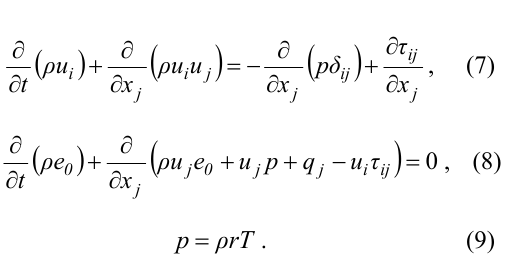
Fig. 4. Schematic of the ejector model with boundary conditions.